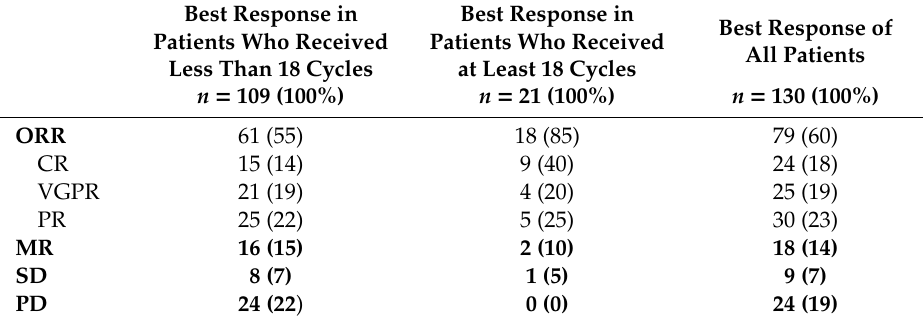
Table 4. Response to KRd in 130 relapse and refractory multiple myeloma (RRMM) treated with KRd as salvage regimen in a real-life approach. according to International Myeloma Working Group (IMWG)